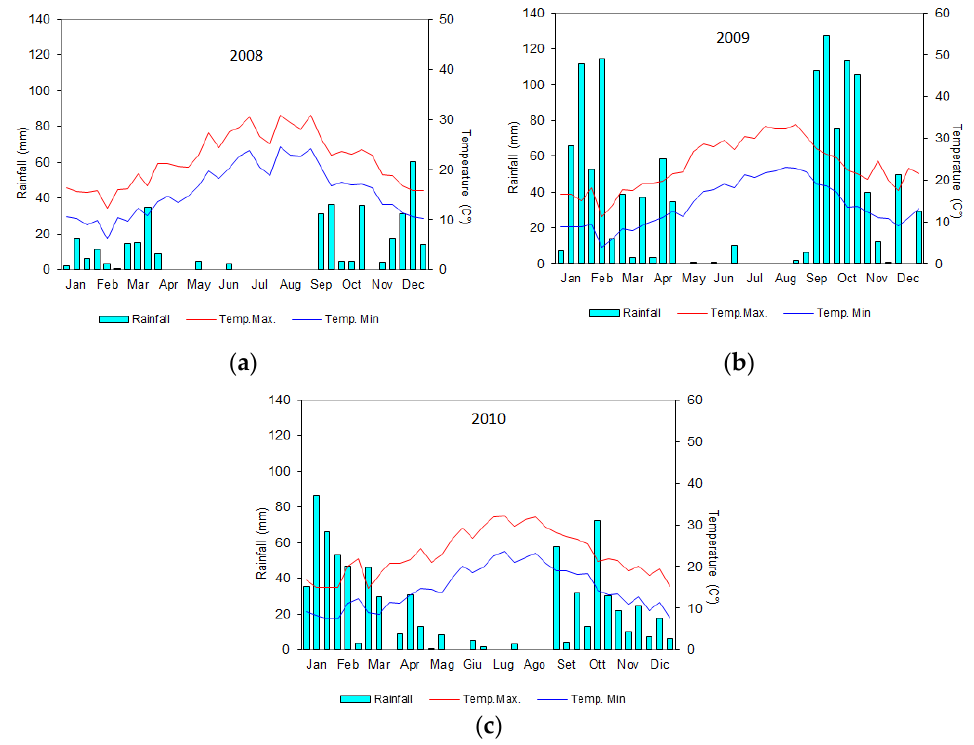
Figure 3. Orleans (Palermo, PA). Rainfall and temperature trends during the test period. Graph ( a ) refers to 2008, graph ( b ) refers to 2009 and graph ( c ) refers to 2010.